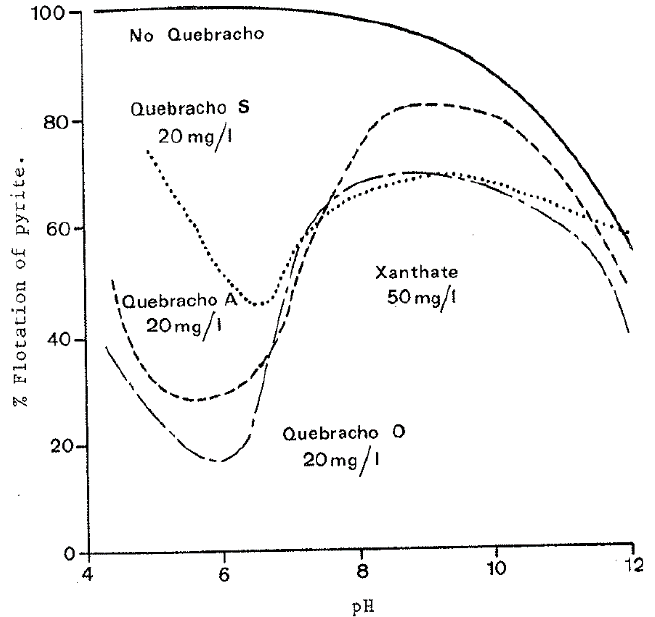
Figure 5. Depression of oxidized pyrite with addition of xanthate and quebracho